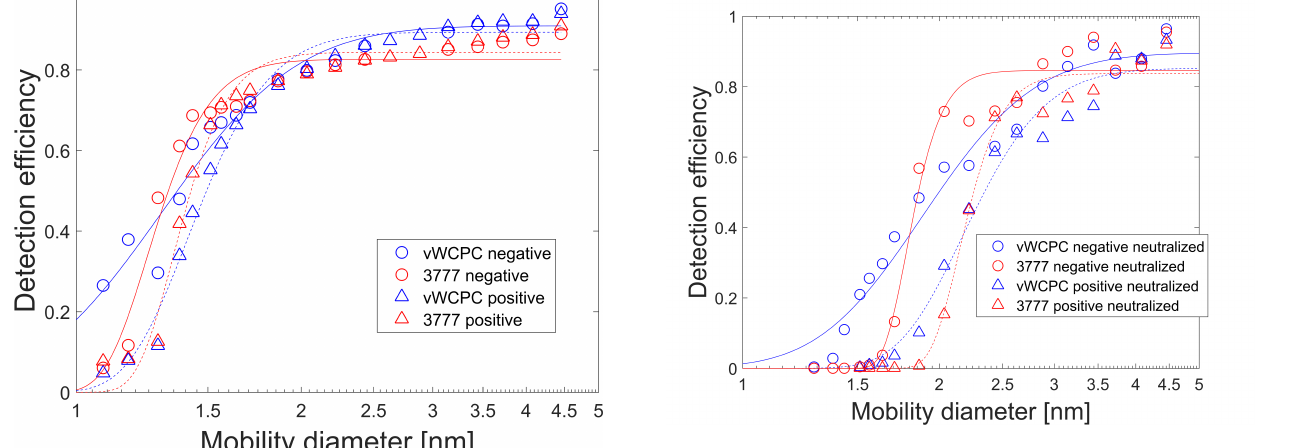
Figure 7. Detection efficiency of the CPCs as a function of size for negatively and positively charged tungsten oxide particles that are neutralized at low dT